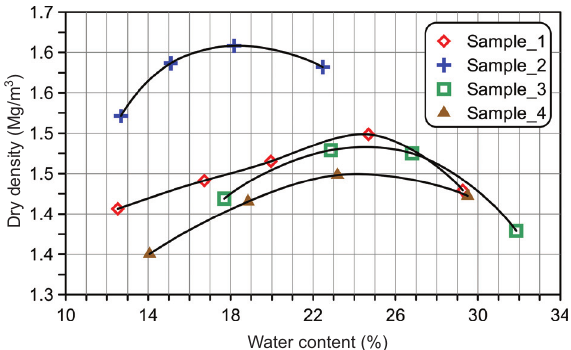
Figure 2 Compaction curves of the soil